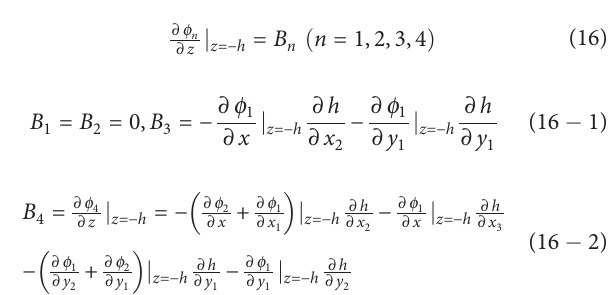
The variable of the bottom boundary condition (2) is expanded into a perturbation series to the fourth order, yielding